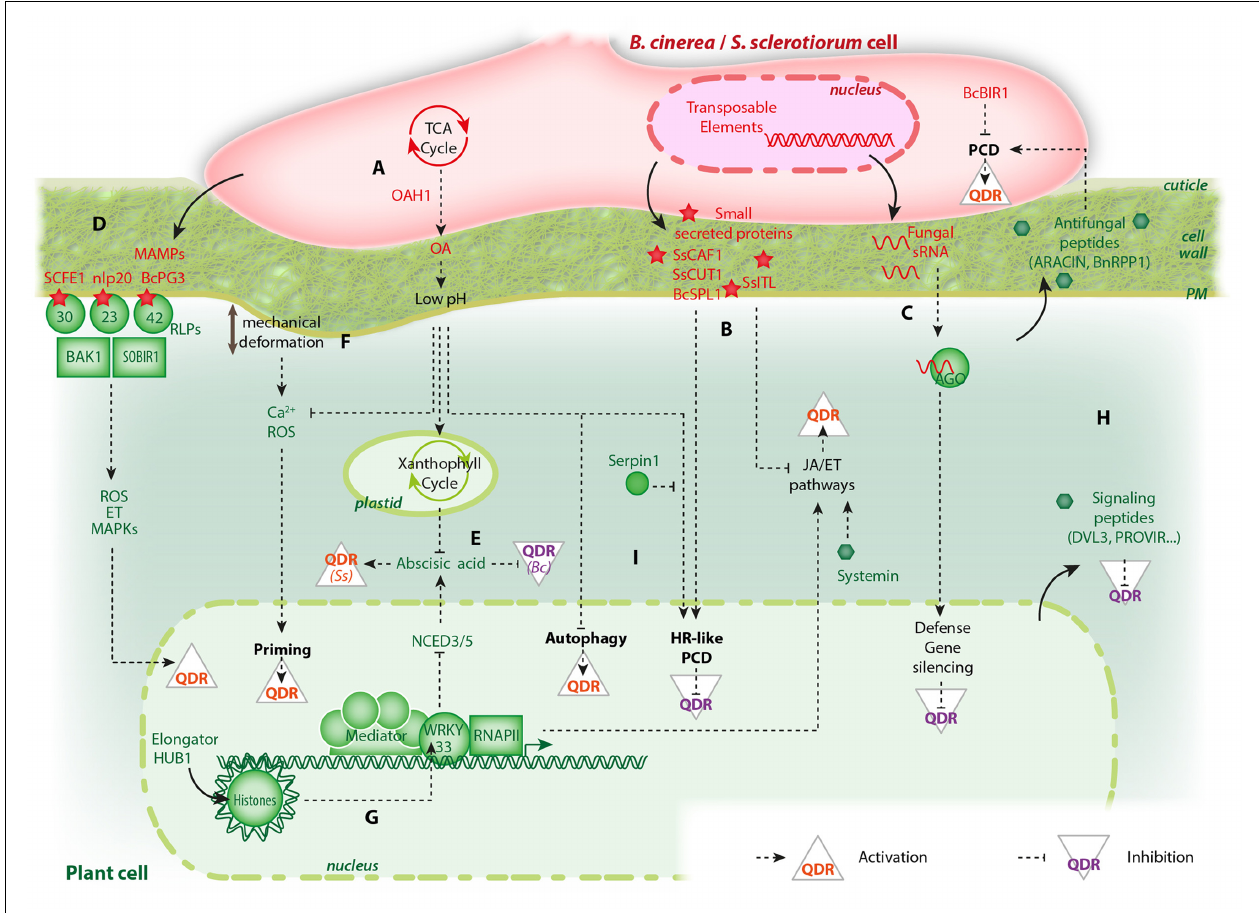
FIGURE 1 | An overview of the molecular players involved in Botrytis cinerea / Sclerotinia sclerotiorum interactions with plants and their effect on quantitative disease resistance (QDR). Only pathways discussed in this review are shown, some elements were omitted for clarity. Fungal molecules are shown in red, plant molecules in green. (A) Effects of oxalic acid (OA) biosynthesis and secretion by fungi. (B) Small proteins secreted by fungi can activate hypersensitive response (HR)-like programmed cell death (PCD) or suppress jasmonic acid (JA) and ethylene (ET) signaling pathways to suppress QDR. (C) Fungal small RNAs hijack plant argonaute (AGO) proteins to suppress QDR. (D) Perception of microbe associated molecular patterns (MAMPs) such as SCFE1, nlp20, and BcPG3 by receptor-like proteins (RLPs) activate QDR. (E) The plant hormone abscisic acid can either activate QDR against S. sclerotiorum (Ss) or suppress QDR against B. cinerea (Bc). (F) Mechanical deformation caused by appressorium formation and fungal colonization of plant tissues prime plant cells for QDR through calcium and reactive oxygen species (ROS). (G) The plant general transcription machinery involves multiprotein complexes such as Elongator and Mediator that recruit the RNA polymerase II (RNAPII) to modulate gene expression upon fungal challenge. Some histone post-translational modifications are epigenetic marks altered after inoculation that regulate the activity of plant general transcription factors and control QDR. (H) Plant small bioactive peptides (green hexagons) have contrasted effects on QDR. (I) PCD in plant cells can either have a positive or negative effect on QDR depending on the type of cell death program